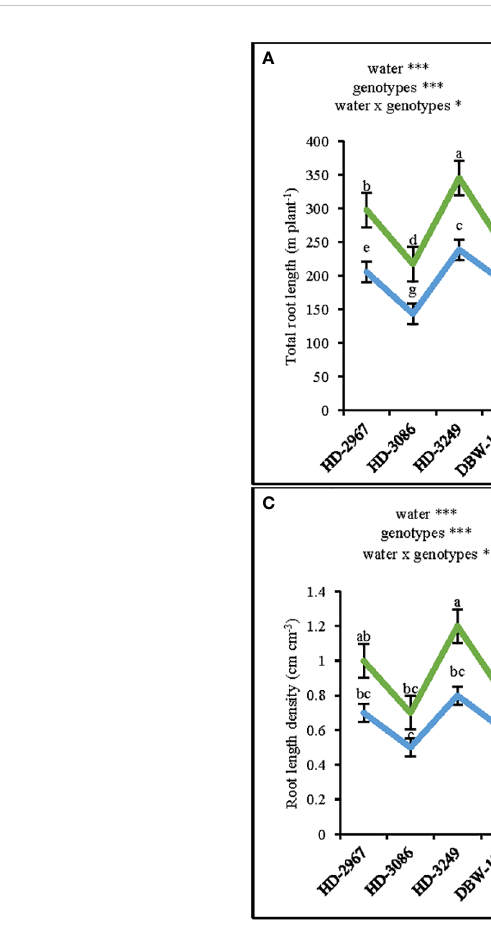
FIGURE 3 Root-system traits of the fi ve wheat genotypes at fl owering (Z61) under well-(WW) and de fi cit- (DW) watered conditions. (A) : total root length, (B) : root biomass, (C) : root length density and (D) : root: shoot ratio. Letters above the lines and bars indicates signi fi cant difference among genotypes at p<0.05(Turkey ’ s HSD test). Signi fi cant at *0.05, **0.01, and ***0.001 probability